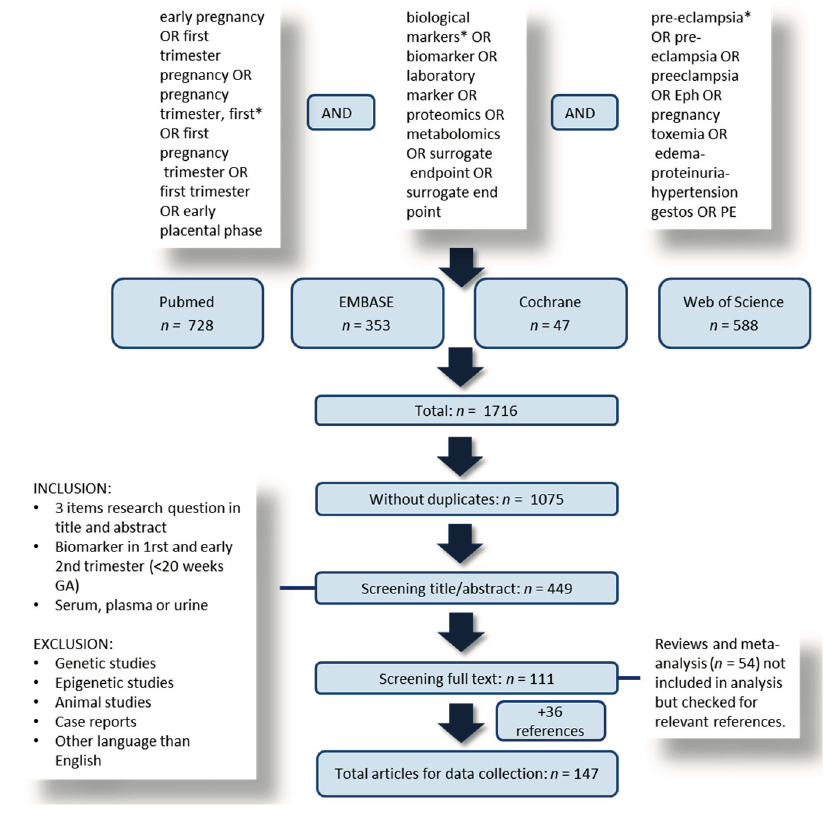
Figure 1. Flowchart of selection process. GA: gestational